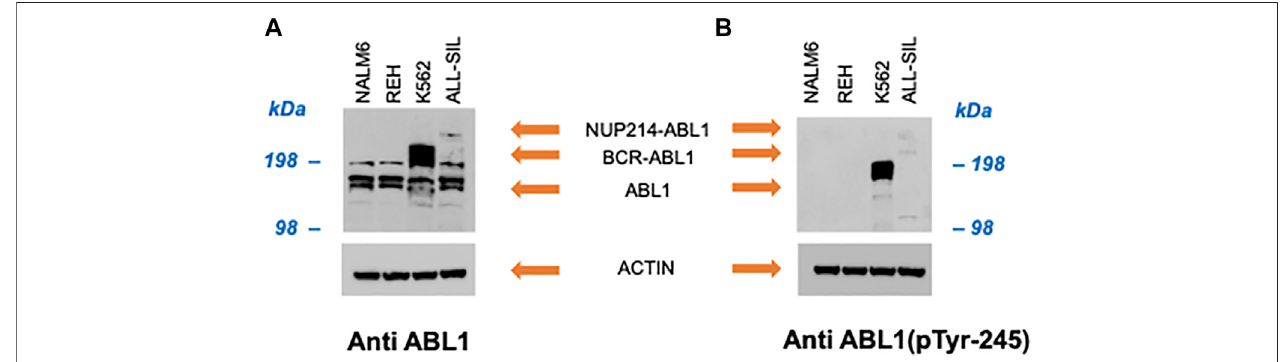
FIGURE 3 | Western blot with (A) anti human ABL1 and (B) anti human phospho-ABL1. Actin was used as loading